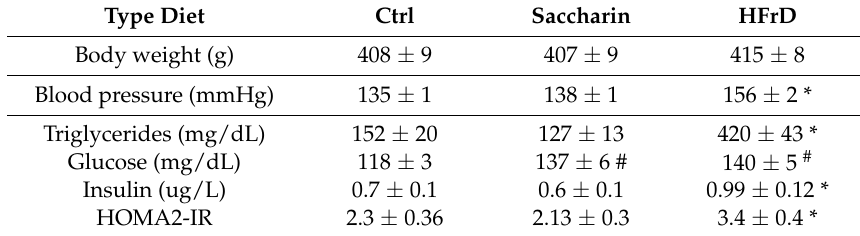
Table 3. Rats’ body weight, blood pressure, and triglyceride levels while on the various diets **. Type Diet